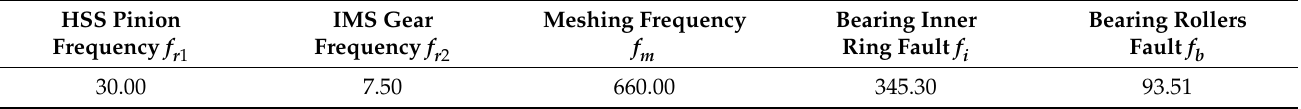
Table 3. Characteristic frequency of faulty